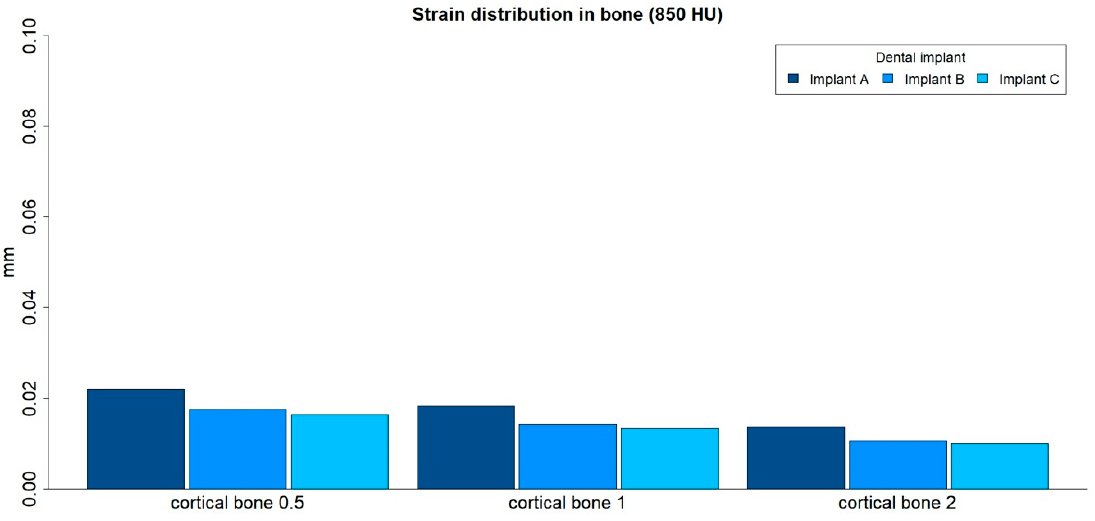
Figure 3. Strain distribution (mm) in low-density medullar bone (150 HU) for all cortical thicknesses (0.5 mm, 1 mm, and 2 mm) in all implant designs: A, B, and C.